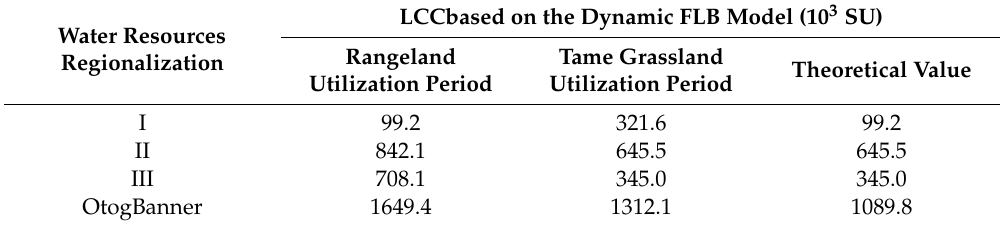
Table 4. LCC based on the Dynamic FLB in OtogBanner.